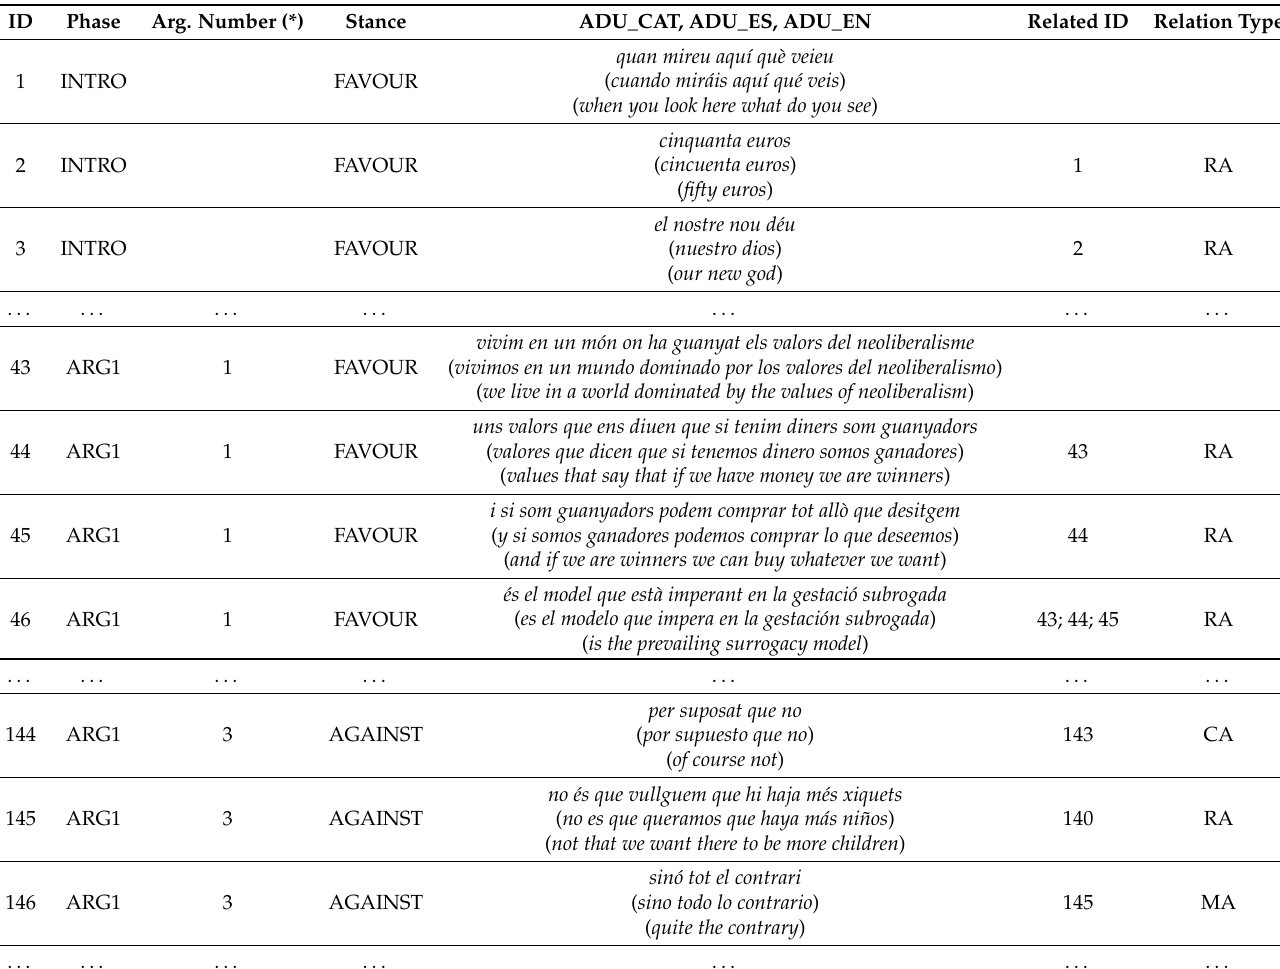
Table 2. Structure of the VivesDebate corpus CSV documents ( Debate7.csv ). (*) An empty value in the Arg. Number column indicates that the ADU does not explicitly belong to any argument presented by the Favour or Against team to specifically support their